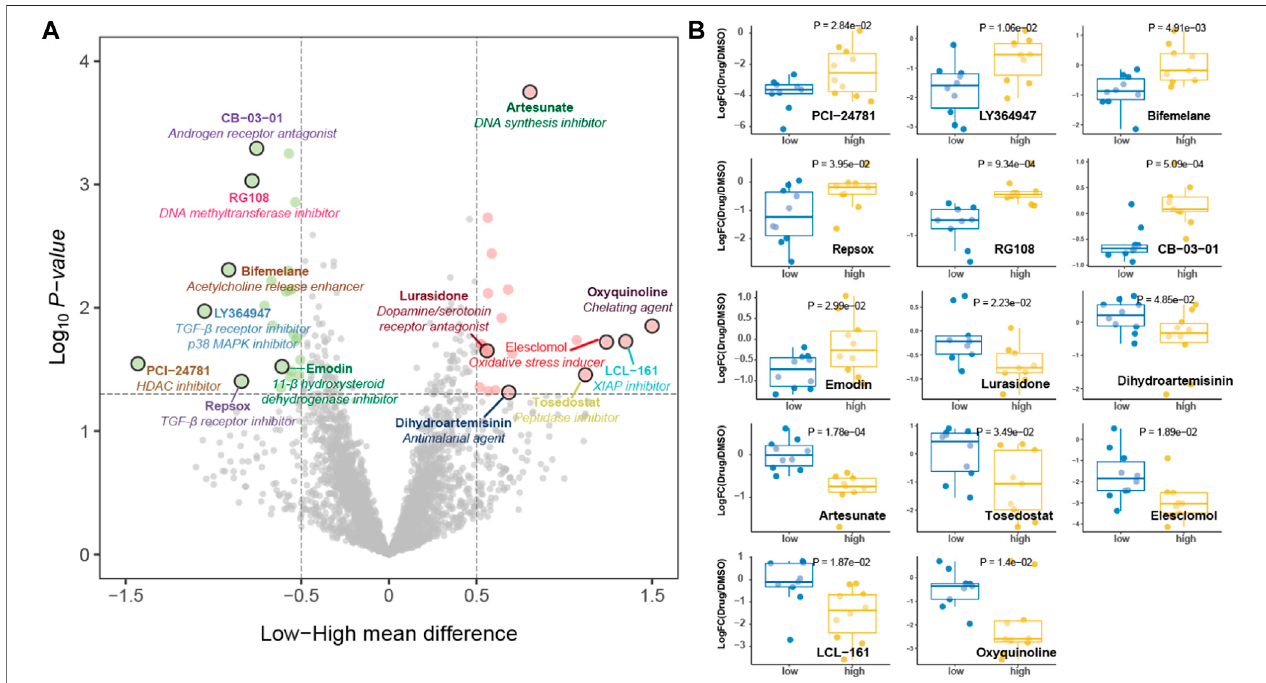
FIGURE11| Potentialantitumordrugscreeningbasedonpyroptosisriskscore. (A) Volcanoplotdepictingthesensitivedrugsforgastriccancercelllineswithhigh- (red) and low- (green) pyroptosis risk score. (B) Dot plot showing the fold change of viability values treated with potential targeted drugs compared with DMSO as transformed by